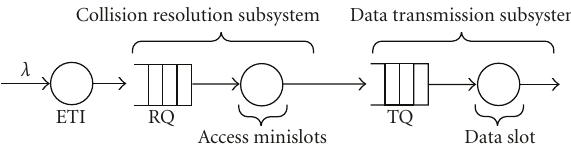
Figure 7: Simplified DQMAN model for average busy period